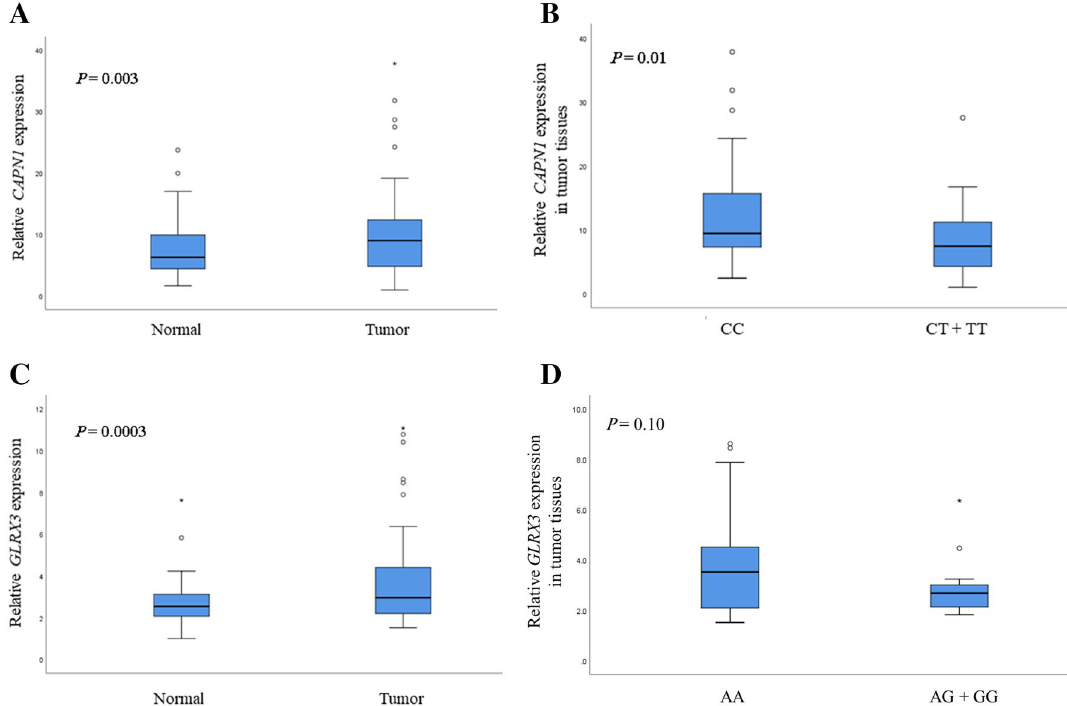
Figure 3. The mRNA expression levels of CAPN1 and GLRX3 in tumor and corresponding non-malignant lung tissues ( A , n = 73 and C , n = 55), and CAPN1 and GLRX3 mRNA expression according to CAPN1 rs17583C>T (32CC, 29CT, and 8TT) and LINC00959 rs4751162A>G (32AA, 15AG, and 1GG) genotypes ( B , D ). The data were analyzed using SPSS. The P -value was calculated using Student’s t-test.